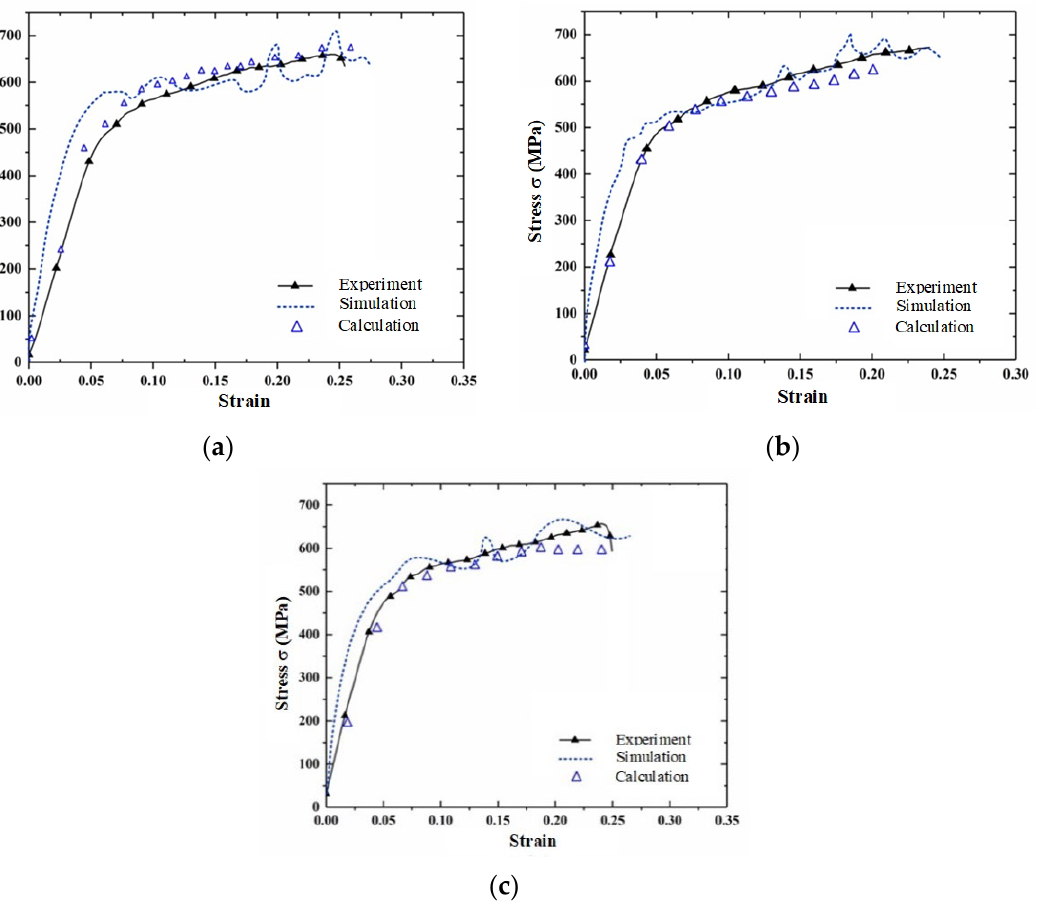
Figure 14. Comparison of test value, simulation value and model value of samples at different angles: ( a ) RD -30°- TD ; ( b ) RD -45°- TD ; ( c ) RD -60°- TD .